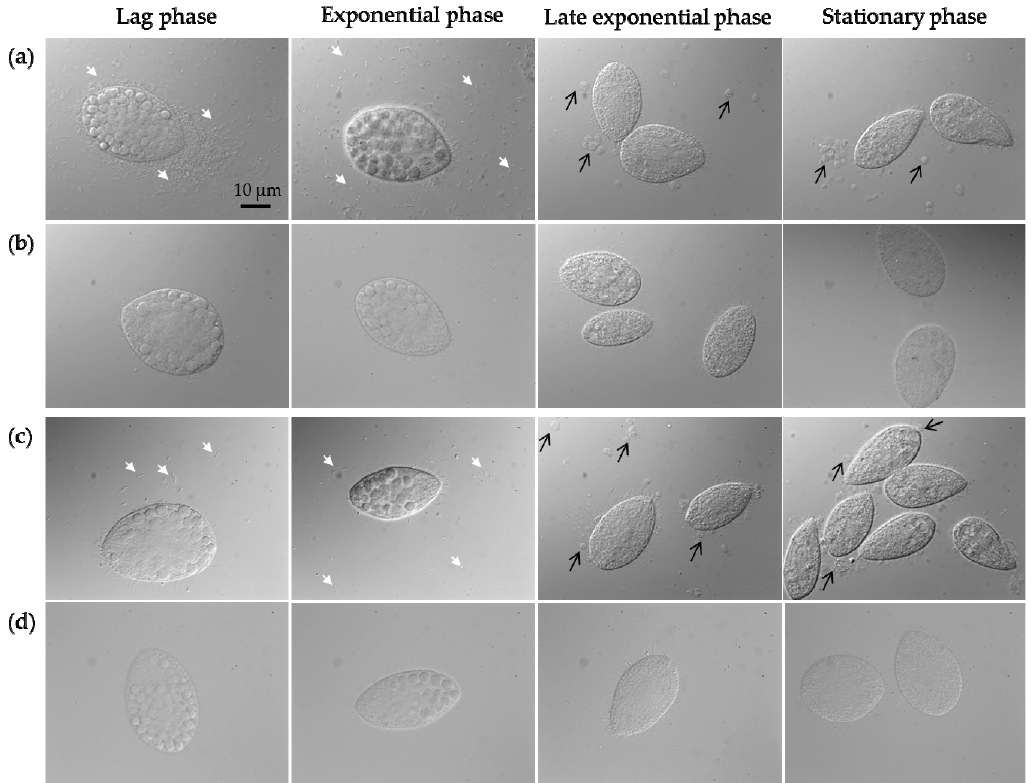
Figure 3. Nomarski images of T. thermophila grown with MWCNT ‐ encrusted bacteria ( a , b ) and control bacteria ( c , d ), taken before ( a , c ) and after ( b , d ) separation steps (differential centrifugation and density gradient centrifugations in iodixanol) at different growth phases. The round shapes inside protozoan cells are food vacuoles filled with bacteria. White arrows indicate bacteria provided as food source and black arrows show protozoan fecal pellets, i.e., secreted food vacuoles containing digested or partly digested bacteria.